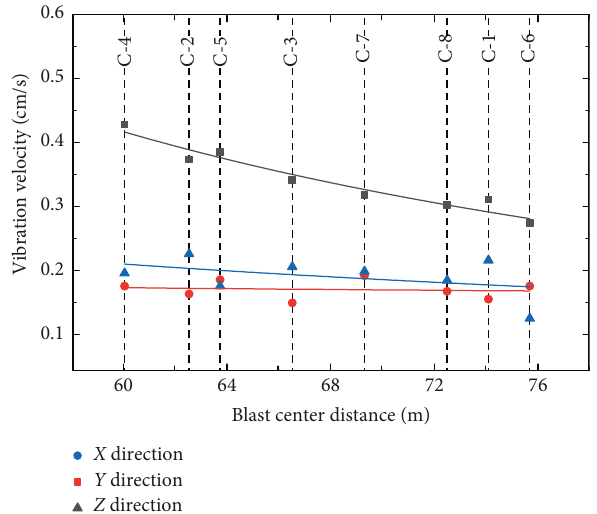
Figure 14: Relationship between the vibration velocity and the blast center distance of the lower step.